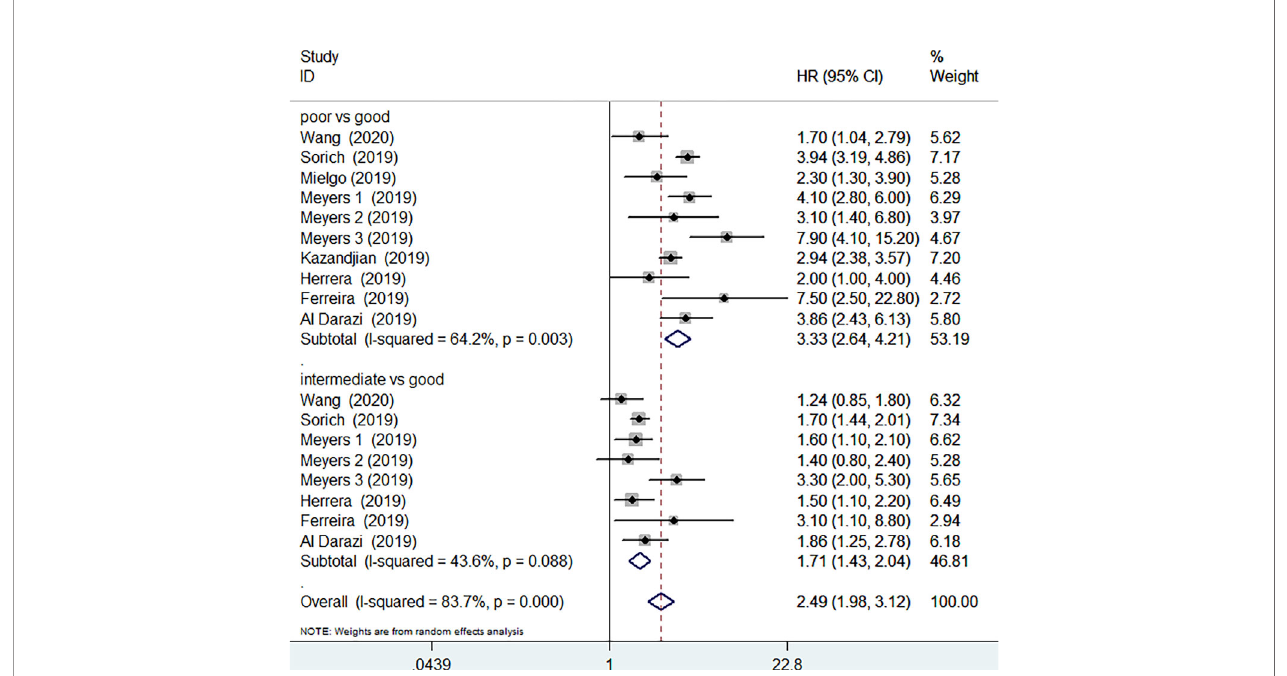
FIGURE 2 | Meta-analysis of OS in cancer patients after ICIs treatment (poor LIPI score groups vs. good LIPI score groups, intermediate LIPI score groups vs. good LIPI score groups).